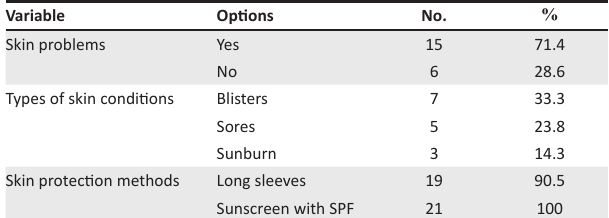
TABLE 3: Utilisation of skin protection. TABLE 2: Utilisation of eye care